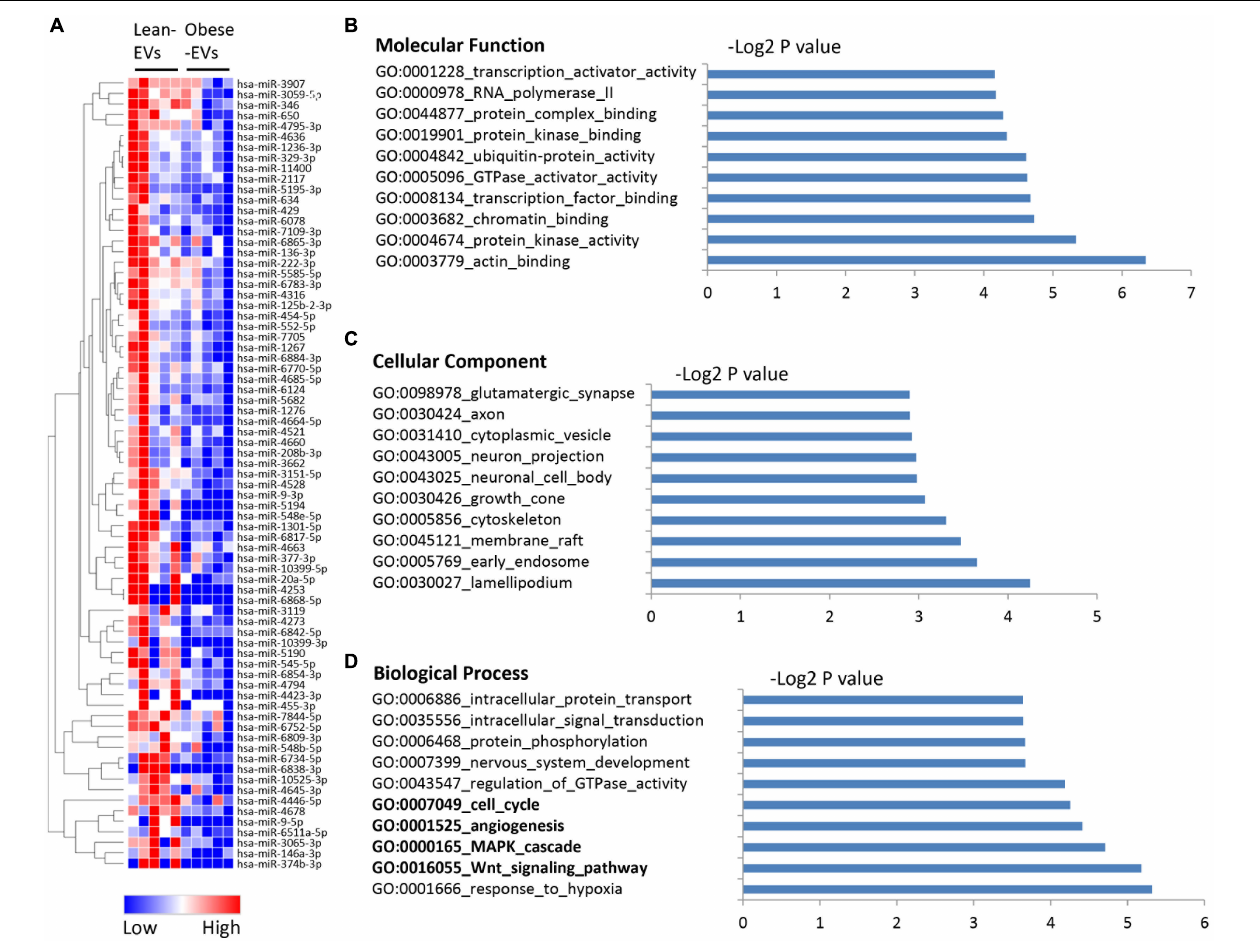
FIGURE 3 | Downregulated miRNA in human ASC-derived EVs and their gene targets. Heat map of miRNAs downregulated in obese-EVs vs. lean-EVs (A) . GSEA analysis of the molecular function (B) , cellular component (C) , and biological process (D) of gene targets of miRNAs upregulated in